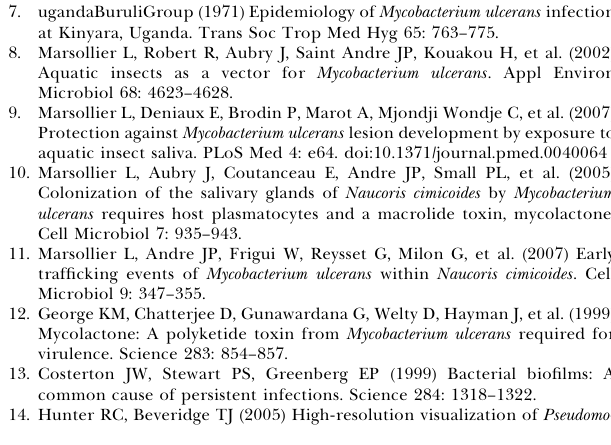
Found at doi:10.1371/journal.ppat.0030062.sg001 (8.7 JPG). Table S1. Detailed Annotation of Proteins Localized in Vesicles of M. ulcerans Found at doi:10.1371/journal.ppat.0030062.st001 (117 KB